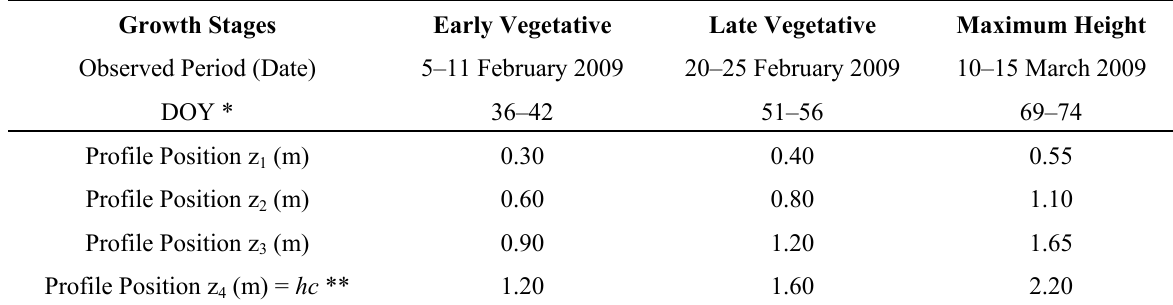
Table 1. Micrometeorology measurement days and sensor position (z ground surface levels of the micrometeorology